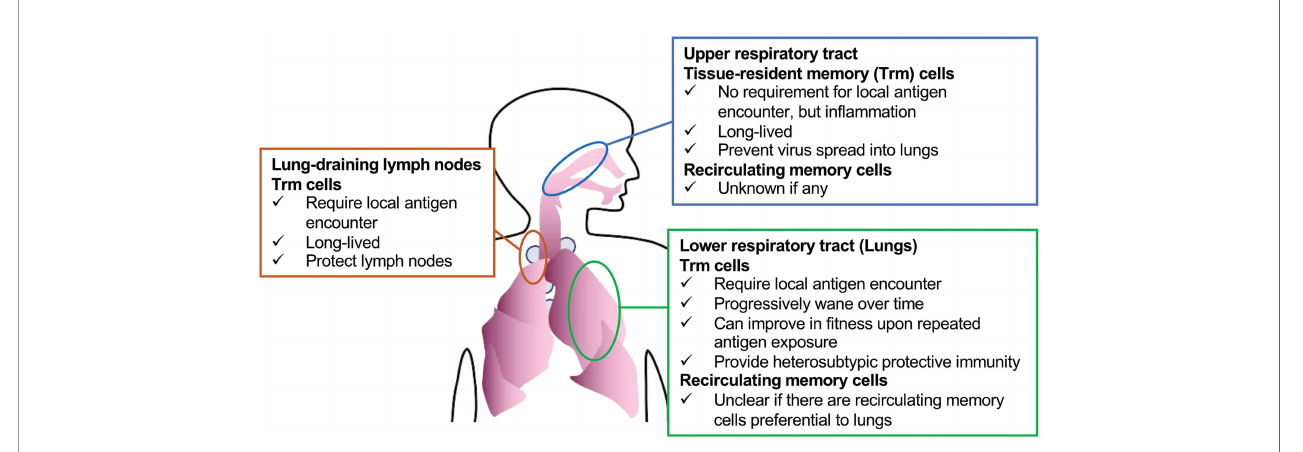
FIGURE 1 | Subsets of CD8 + T cells (Trm cells and recirculating memory cells) that can be targeted to protect against respiratory